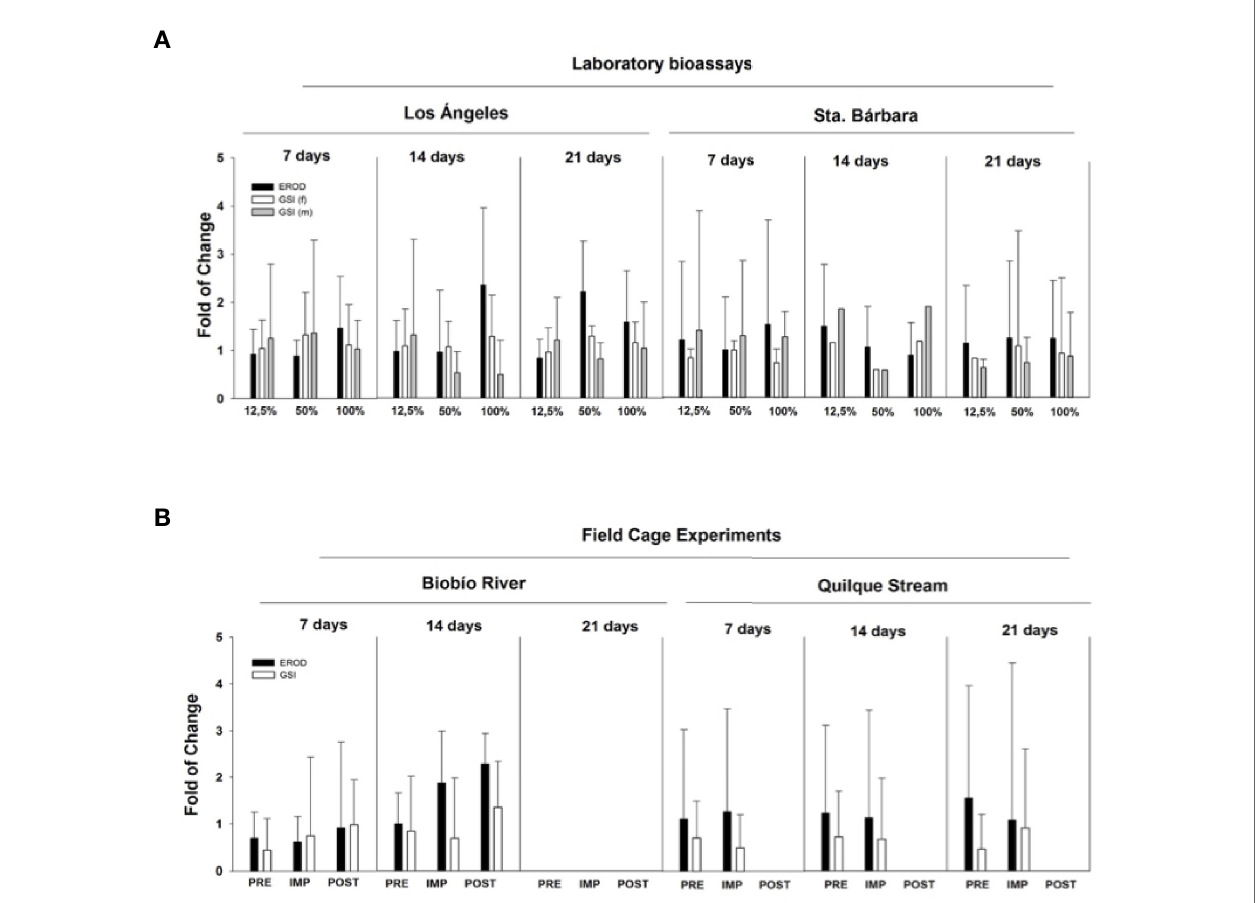
FIGURE 4 | Laboratory bioassays and fi eld cage experiments with Oncorhynchus mykiss exposed to wastewater treatment plant ef fl uents located in Biob ı ́ o River basin. (A) Laboratory bioassay gonadosomatic index (GSI) and ethoxyresoru fi n-O-deethylase (EROD) in females (f) and males (m) exposed to 12.5%, 50%, and 100% ef fl uent for 7, 14, and 21 days. (B) caging experiments show GSI and EROD endpoints after the exposure in river (PRE, pre-impact zone, IMP, impact zone, POST,